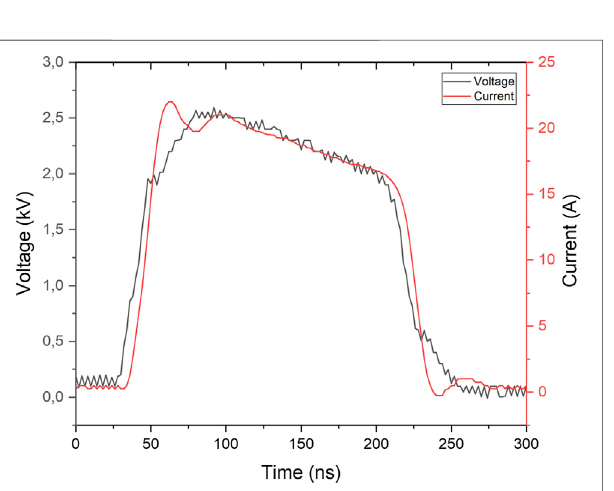
Frontiers in Physics |